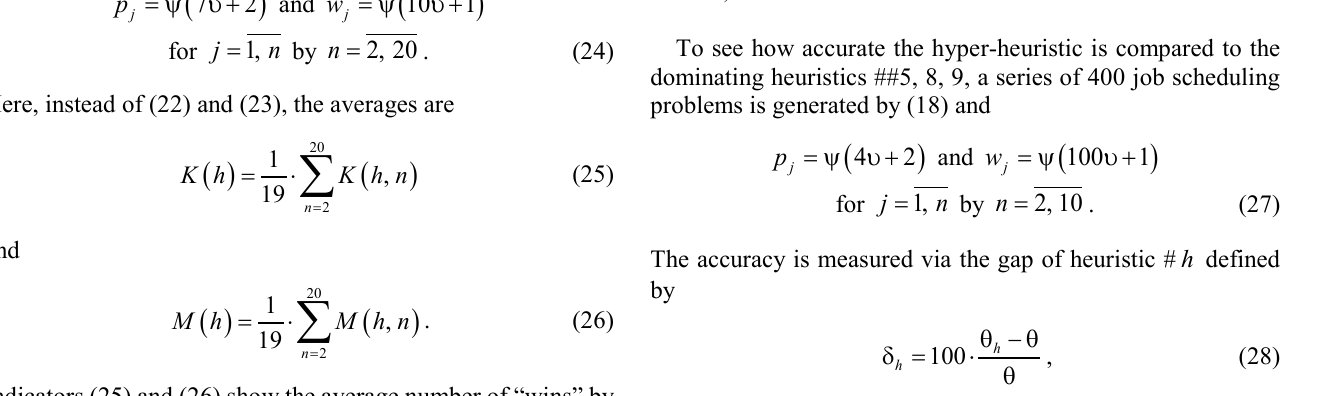
Fig. 4. The average number of times the heuristic “wins” solely (per 1000